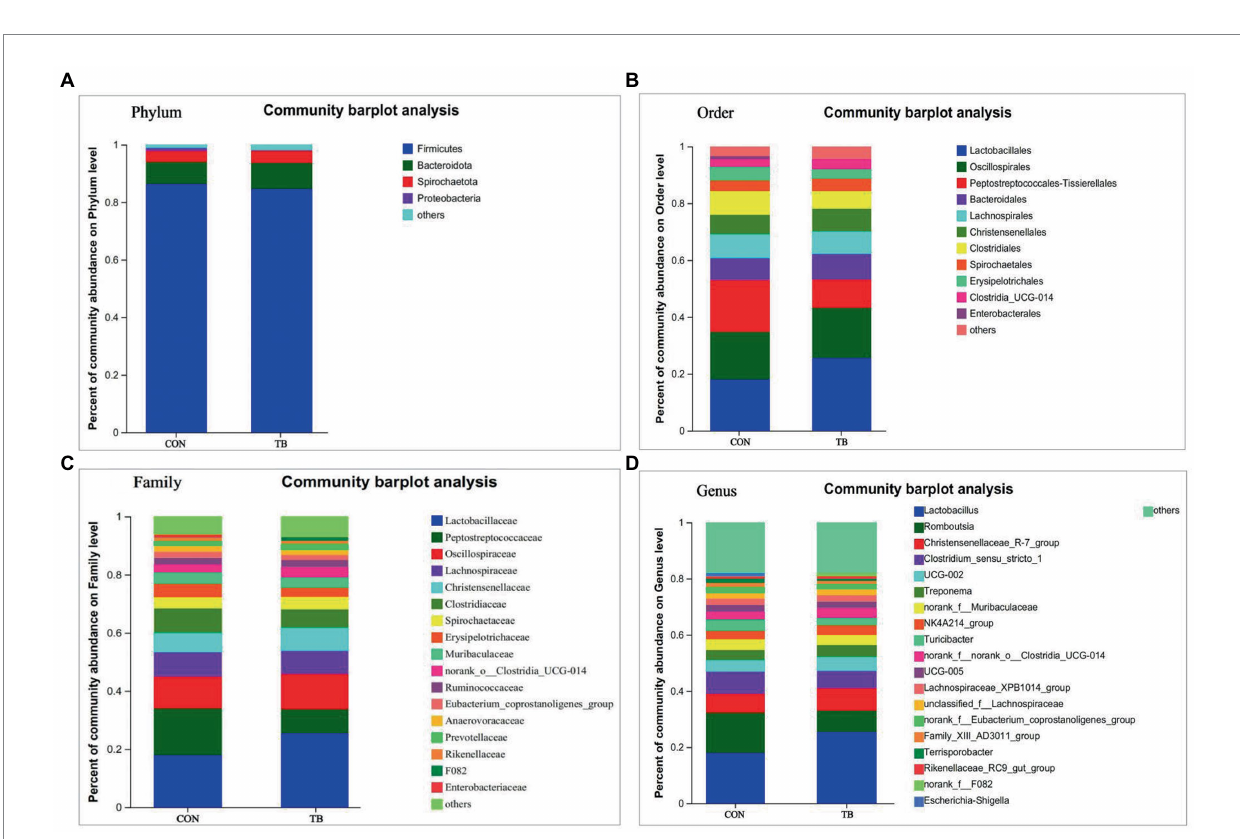
FIGURE 2 Effects of tributyrin on fecal microbial composition of sows. The overall composition of the sow fecal microflora at the phylum (A) , order (B) , family (C) , and genus (D) level is indicated in the bar chart. Each bar graph represents the average relative abundance of each bacterial taxon in a set. The abscissa/ordinate shows the sample name, the ordinate/abscissa shows the proportion of the species in the sample, columns of different colors represent different species, and the length of the columns represents the proportion of the